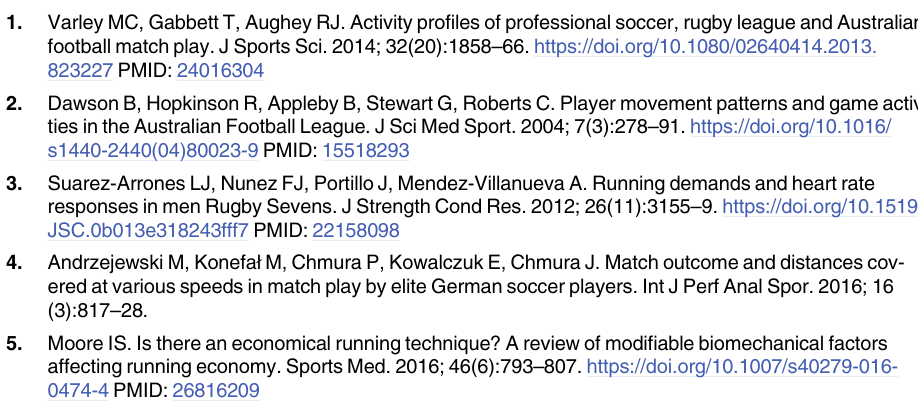
S1 Table. List of legs analysed and joint angles unable to be reconstructed for analysis. Joint angle data that could not be reconstructed is highlighted in red. S2 Table. Pointwise t-statistics and maximum critical values for SPM t-tests. (DOCX) S1 Fig. Hip joint SPM t-test BW versus 1% separated based on condition order. (A) Hip joint BW versus 1% for participants in which 1% condition did not immediately proceed 5% condition. (B) Hip joint BW versus 1% for participants in which 1% condition immediately proceeded 5% condition. Solid lines represent ensemble means and accompanying shaded regions represent ± 1 SD. Grey shaded regions indicate regions of significant difference between curve